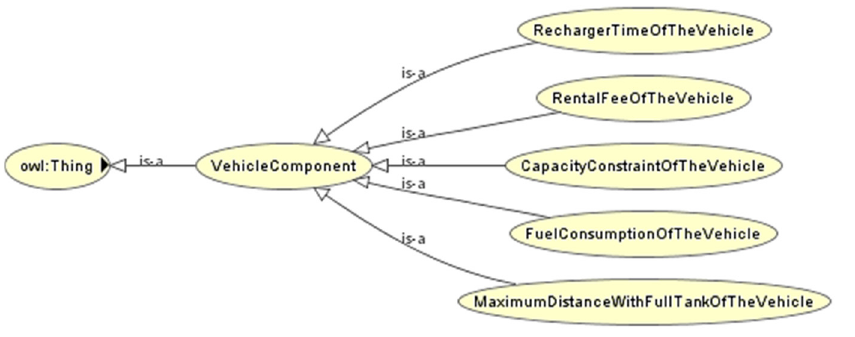
Figure 6. The VehicleComponent class.